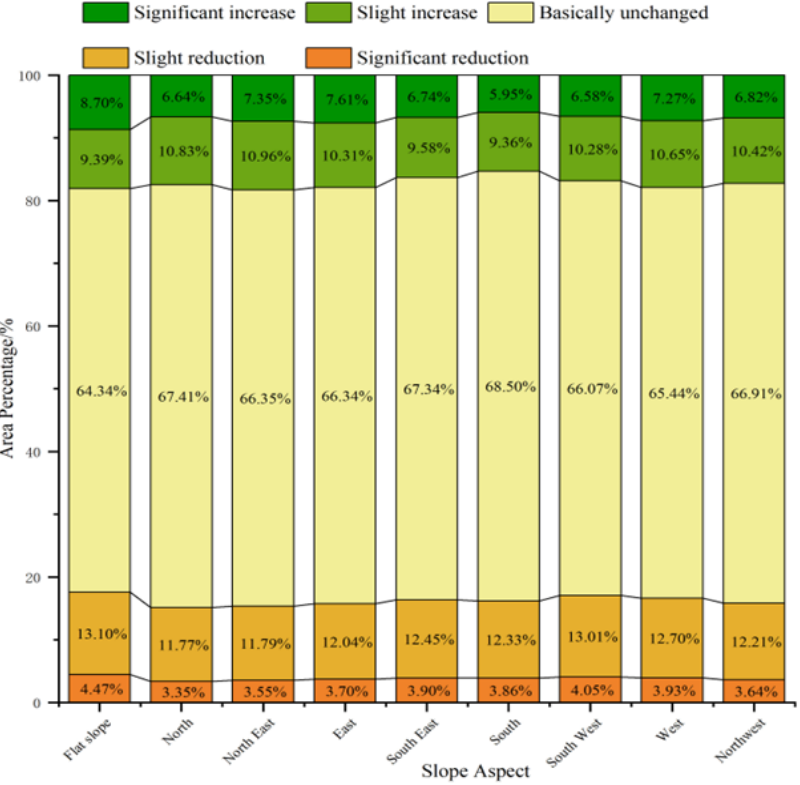
Figure 9. Vegetation cover change statistics of different slope orientations in the Three North Pro- tection Forest Project area.